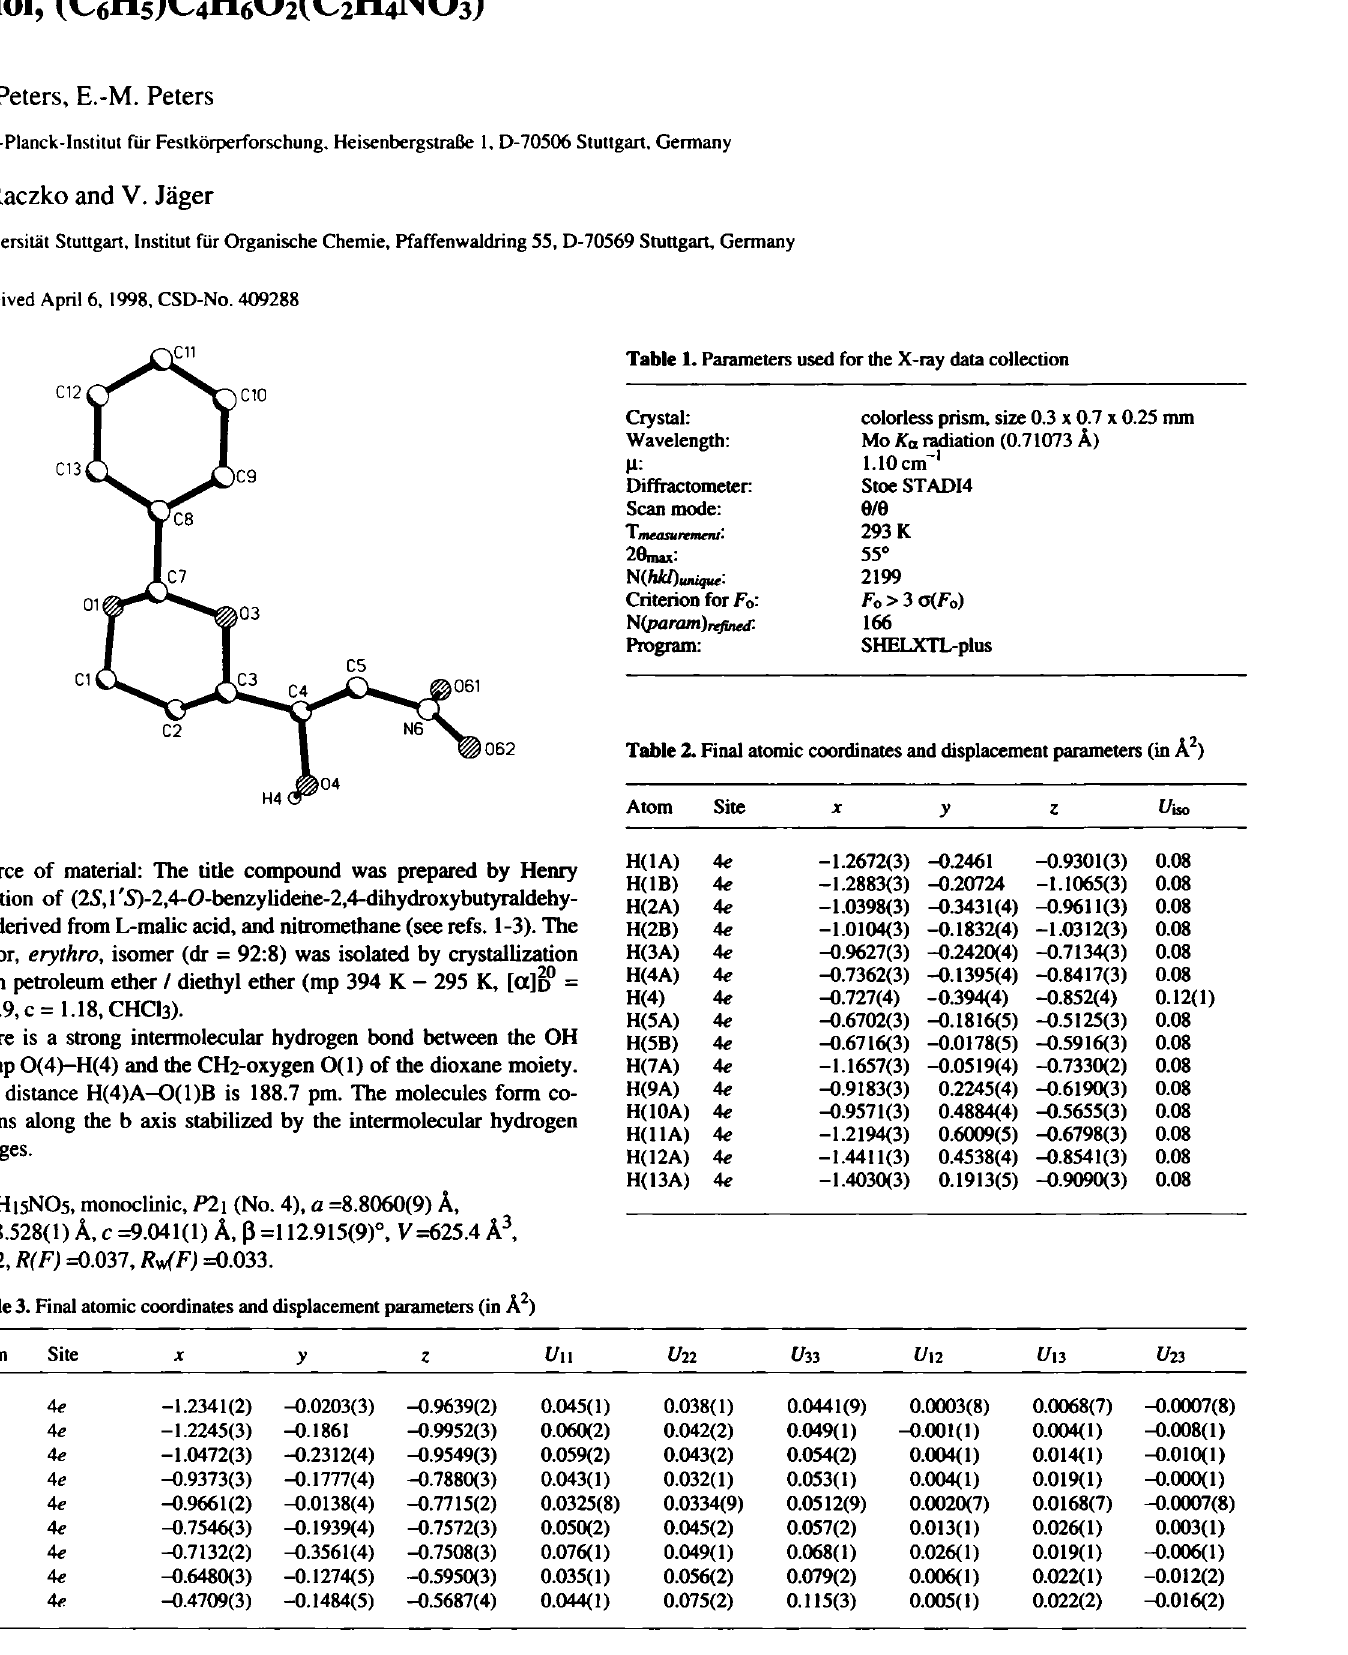
Table 3. Final atomic coordinates and displacement parameters (in Â^)